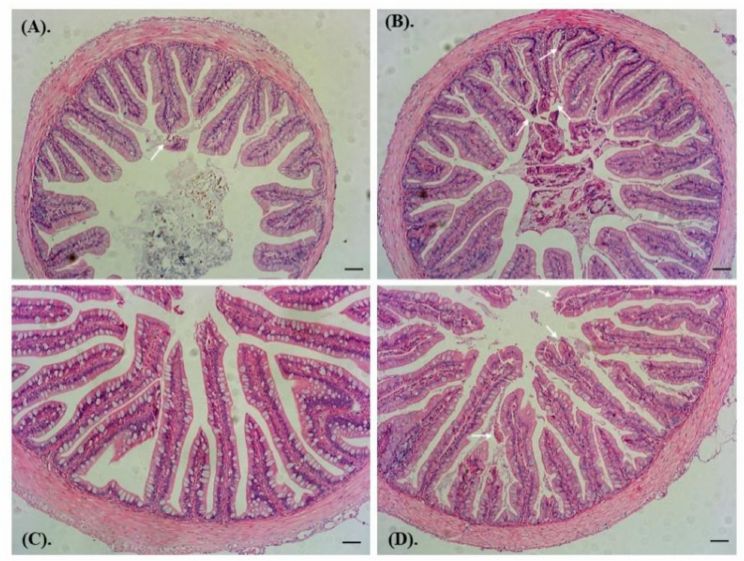
Figure 2. The intestine morphology of largemouth bass in Group A ( A ), Group B ( B ), Group C ( C ) and Control group D ( D ). Scale bar = 50 µ m. White arrow indicates the location of the